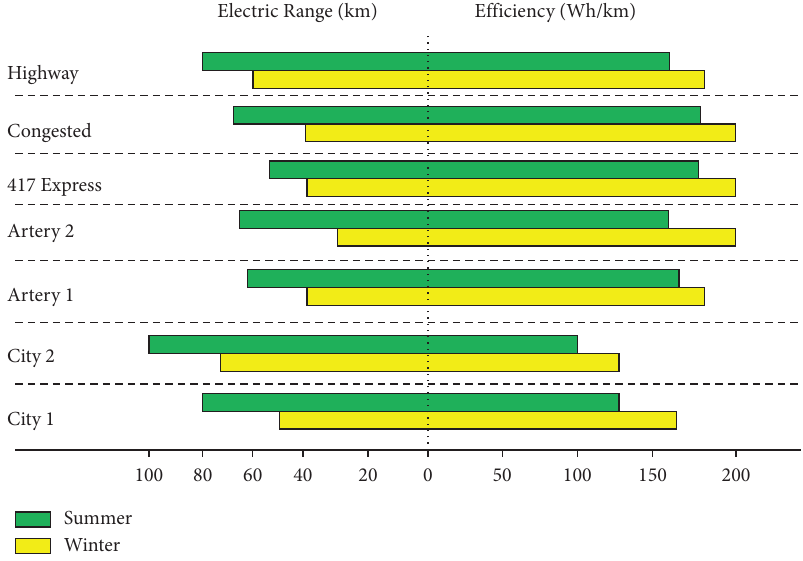
Figure 16: Shows Chevrolet volt Wh/km and average travel distance for diferent seasons [204]. Table 3: Various energy storage performance and a specifcation comparison table with the efect of cost. Energy